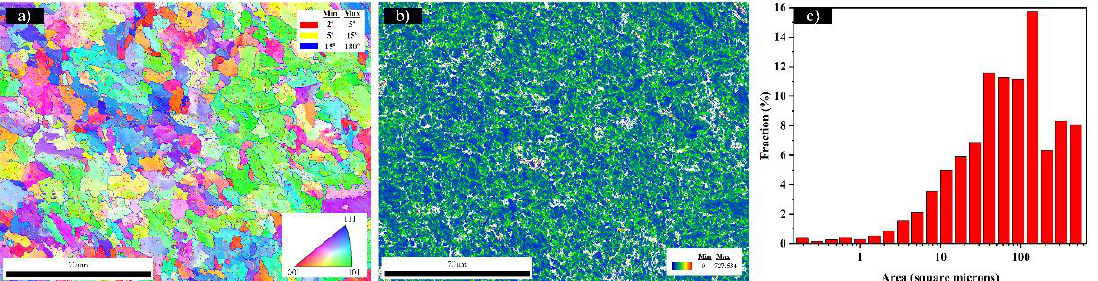
Figure 16. Microstructure information of sample C. ( a ) EBSD orientation map; ( b ) GND map; ( c ) grain area distribution.